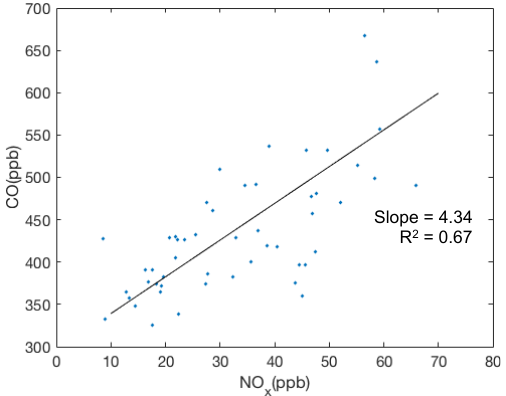
Figure 8. CO vs. NO x measured at Laney College between 08:00 and